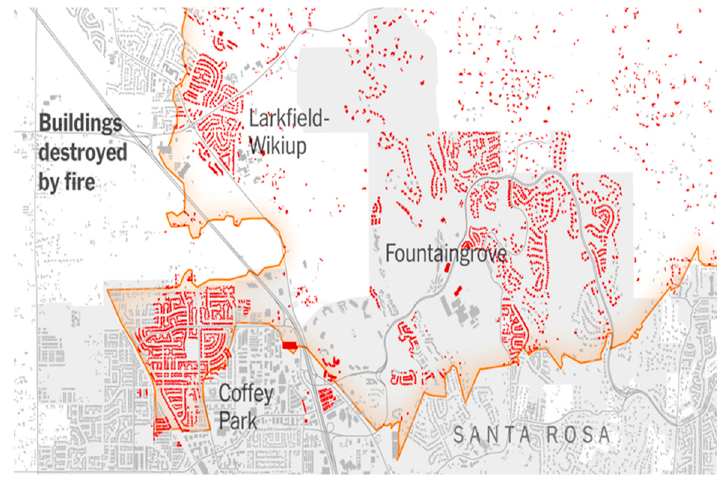
Figure 15. Santa Rosa fire route. Source: New York Times [46].